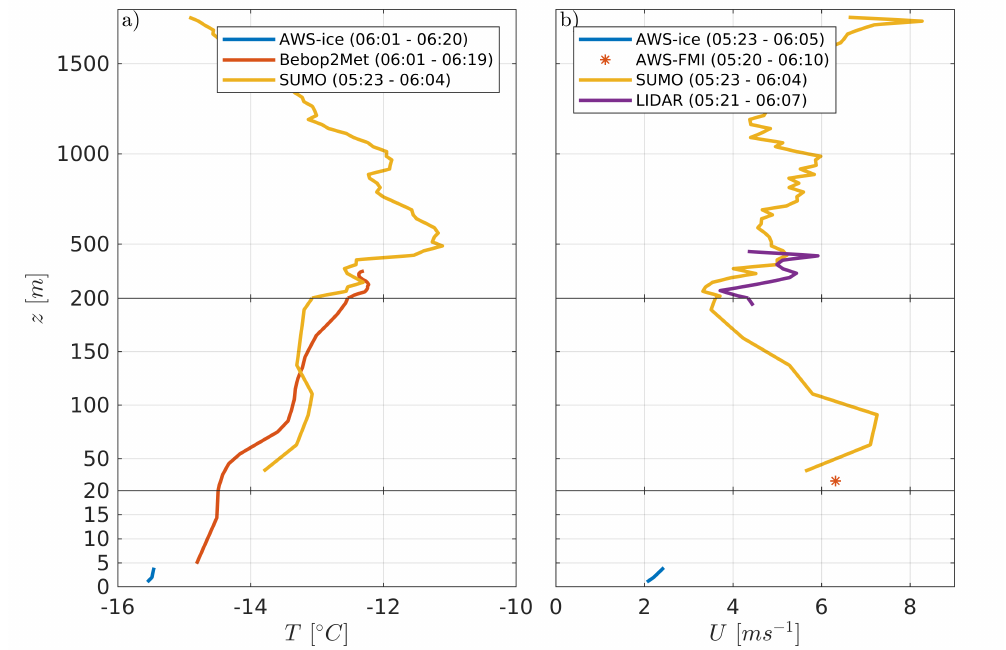
Figure 9. Combined temperature ( a ) and wind speed ( b ) profiles based on AWS-ice AWS-Finnish Meteorological Institute (FMI) (only U ), Bebop2Met ( T ), Small Unmanned Meteorological Observer (SUMO) and LIDAR ( U ) observations from 26 February between 05:20 and 06:20 UTC. The AWS and LIDAR data represent averaged profiles for the periods indicated in the